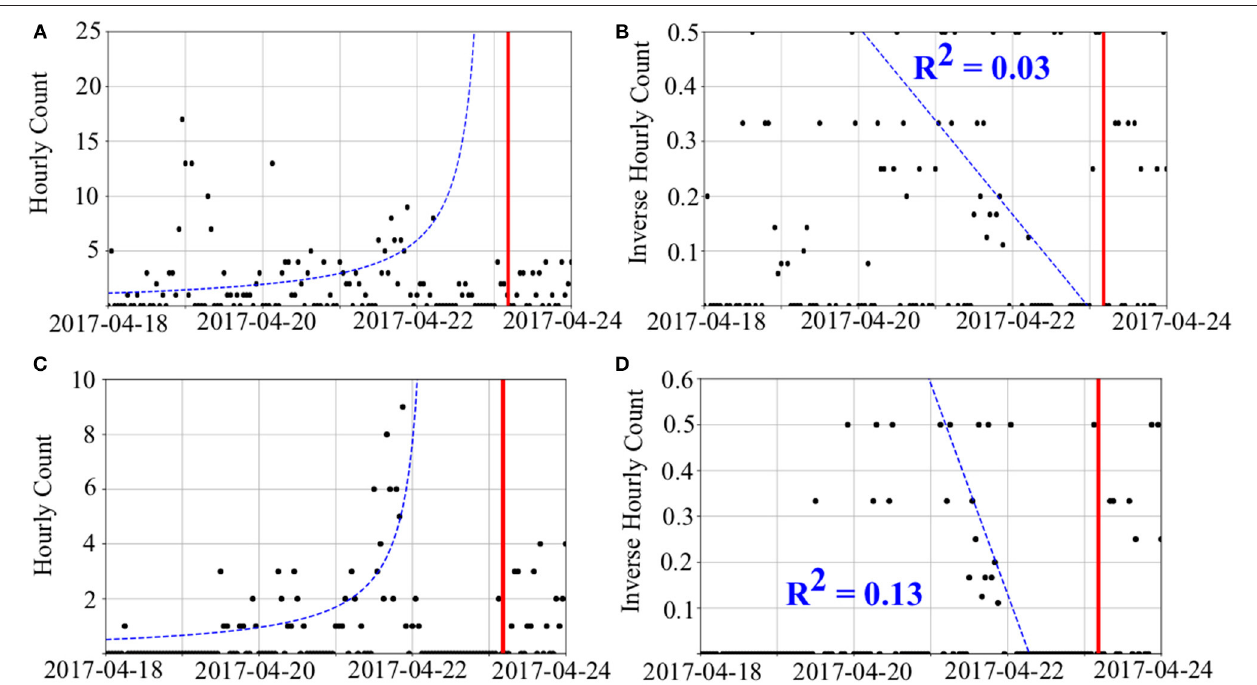
FIGURE 6 | Hourly counts of seismicity and application of the FFM prior to a large phreatomagmatic eruption at Poás. Each data point represents either: the hourly count of seismic events in that family (A,C) or the inverse hourly event rate (B,D) . The vertical red line represents the known timing of the phreatomagmatic eruption on 23 April at 04:12 UTC. Accelerating trends, and their corresponding least-squares linear regressions are shown by dotted lines. (A,B) represent the hourly counts from all families of seismicity identified during this time period; (C,D) represents data from the dominant LF family of events (30-03-207